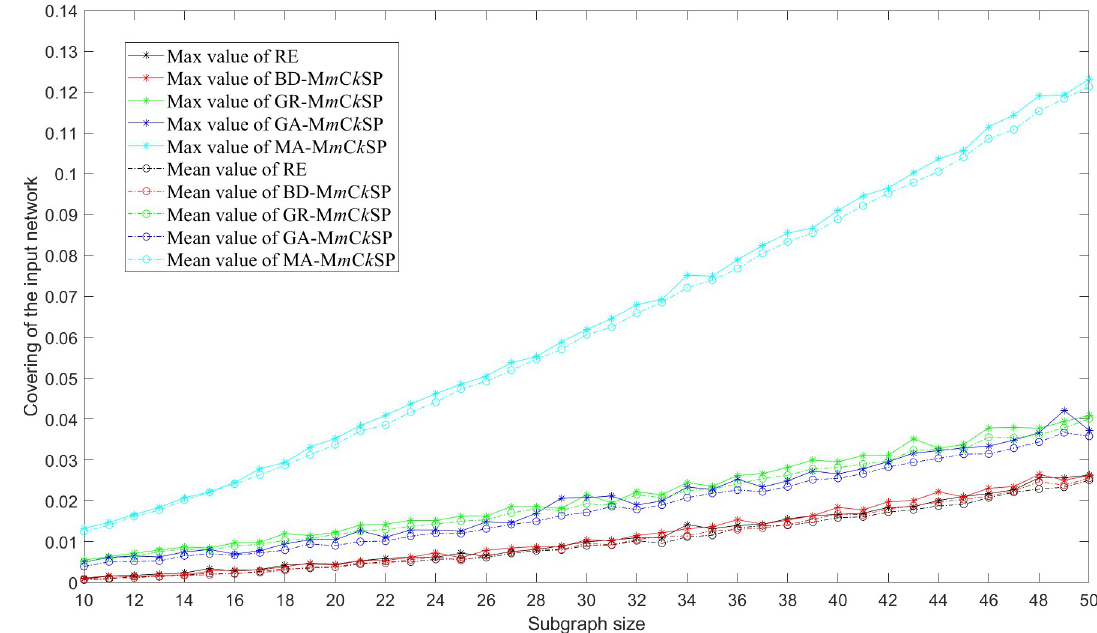
Fig 12. Covering of the 1000-node input random network acquired by RE, BD-M m C k SP,GR-M m C k SP,GA-M m C k SPand MA-M m C k SPfor different subgraph sizes given the number of subgraphs m = 10.